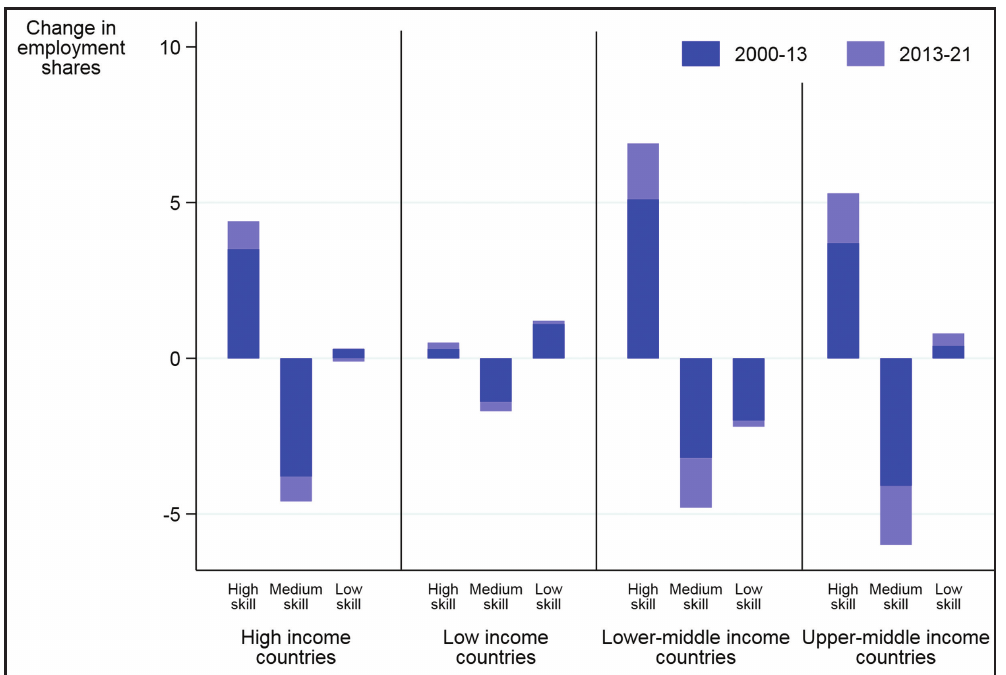
Figure 3 Job polarization around the world,